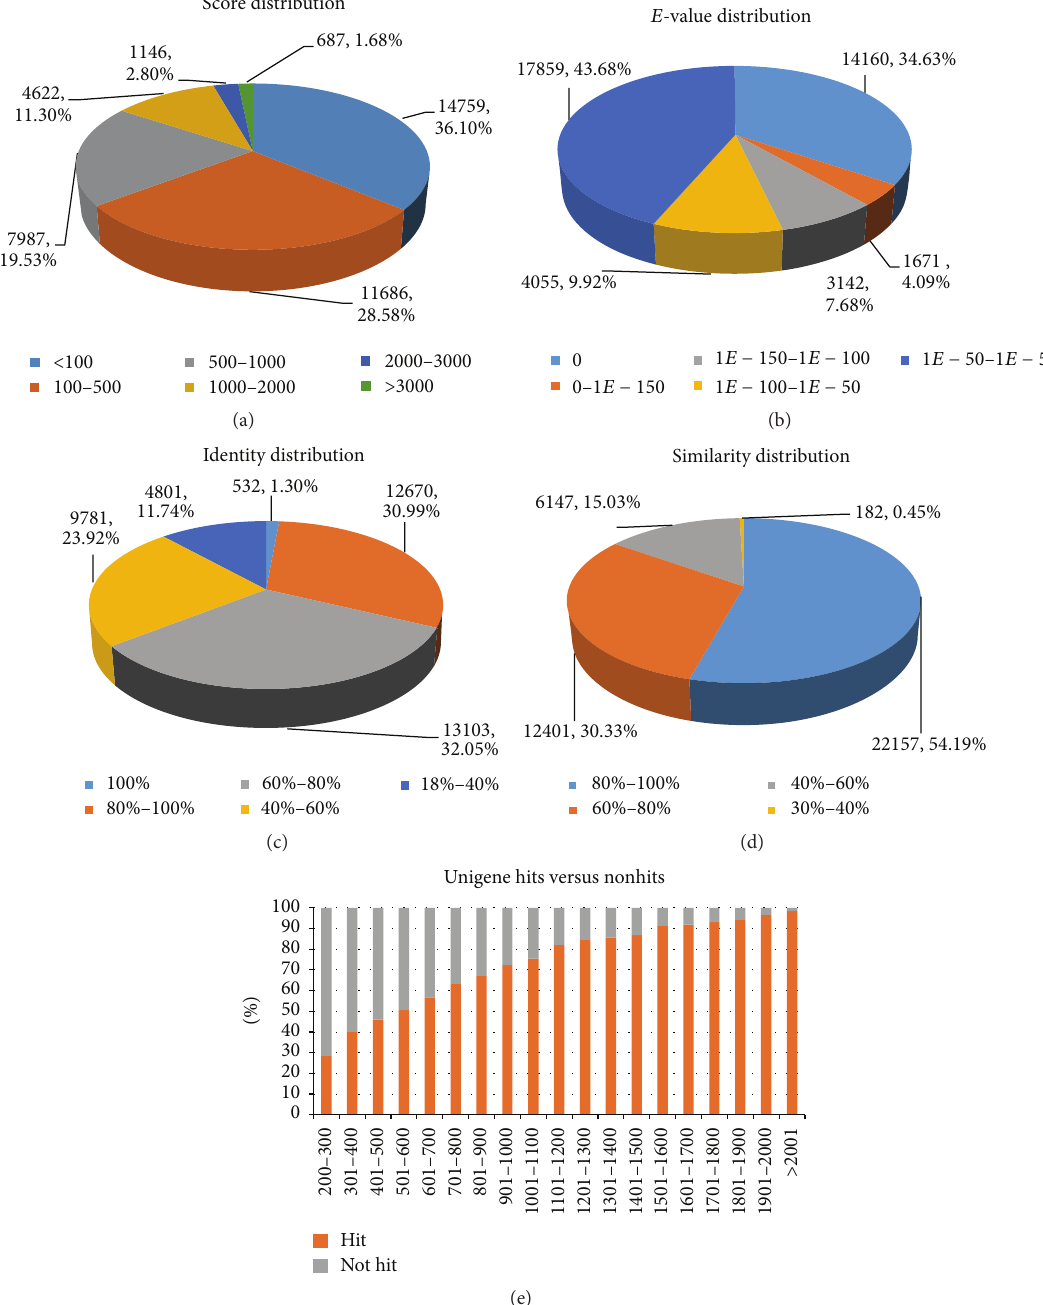
Figure 2: Summary of homology search of assembled unigenes of V. mandarinia against PANM-DB. (a) Score distribution of BLASTX hits for each unigene with a cutoff 𝐸 -value of 1𝐸 − 5 . (b) 𝐸 -value distribution of BLASTX hits for each unigene with a cutoff 𝐸 -value of 1𝐸 − 5 . (c) Identity distribution of BLASTX hits for each unigene. (d) Similarity distribution of BLASTX hits for each unigene. (e) Distribution of hit and nonhit sequences as compared with the length of